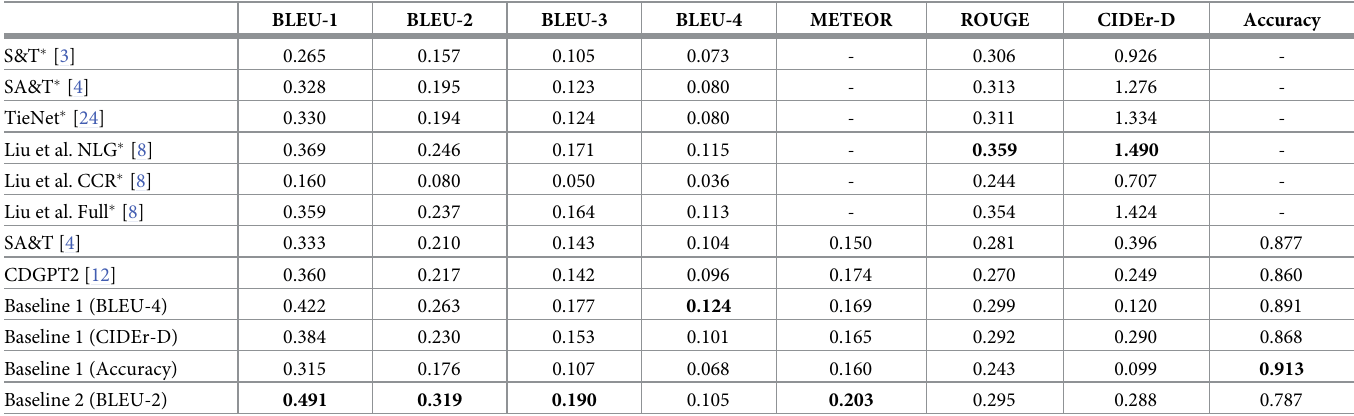
Baseline 1 (Accuracy)